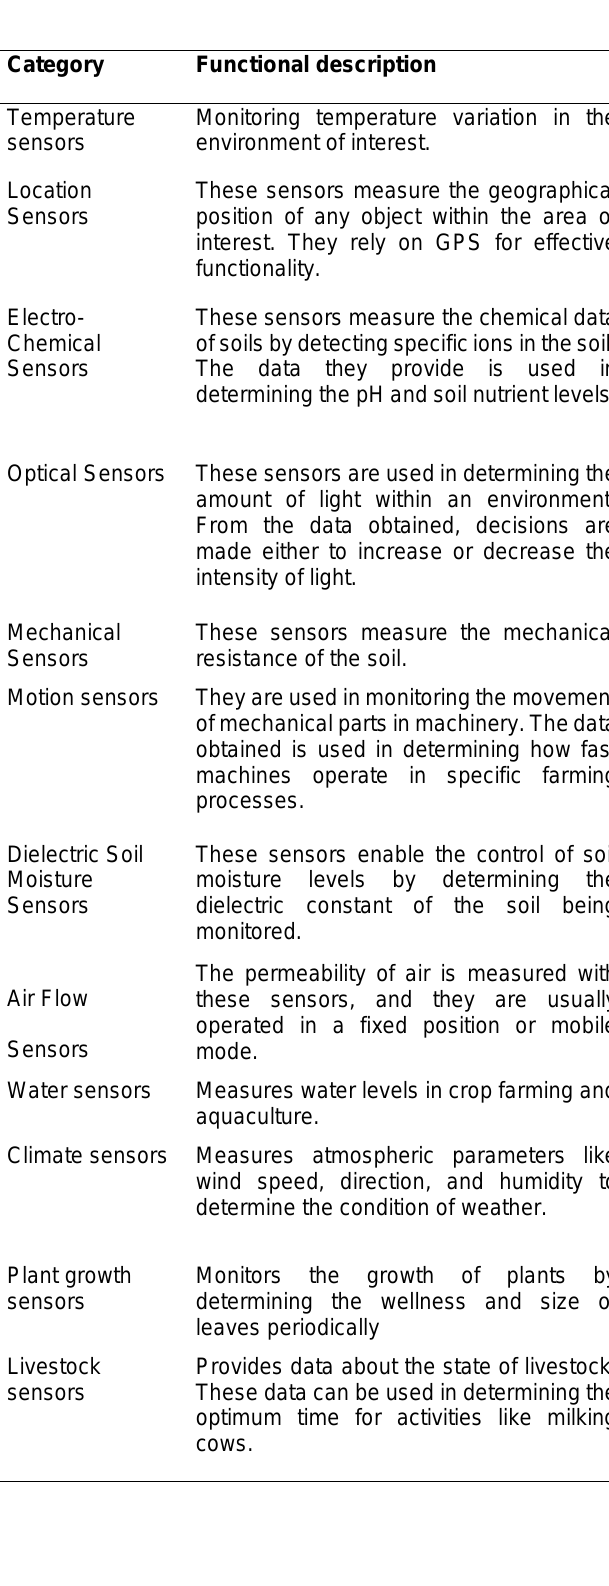
Table 2. Types of data measured by agriculture